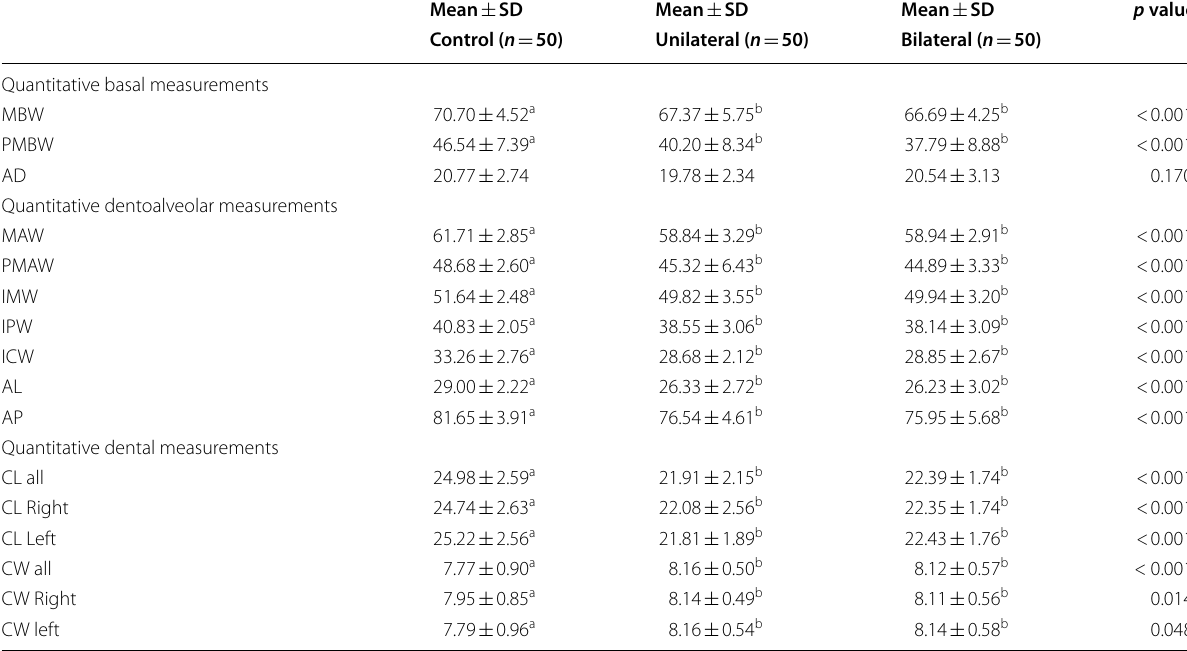
a, b Letters used for significance differences between studied groups; similar letter indicated insignificant difference while different letters indicated significant differences between studied